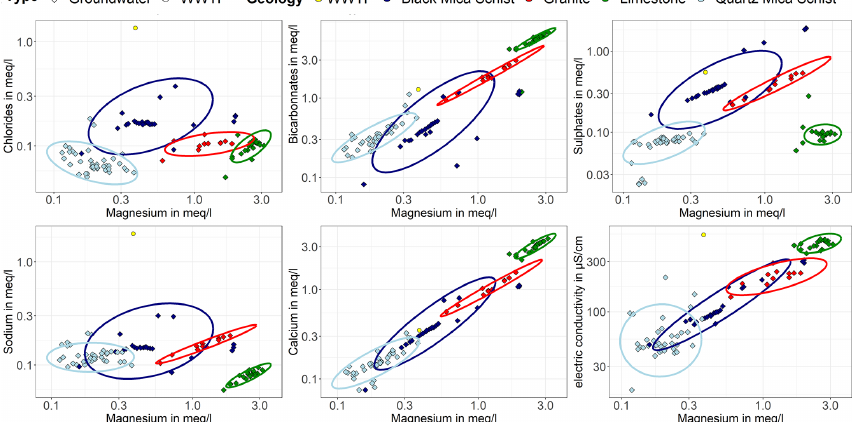
Figure 5. Bivariate solute–solute diagrams of groundwater. The ellipse in the graphs was calculated with stat ellipse (ggplot2 package). The arrows mark the seasonal variation of the different geological